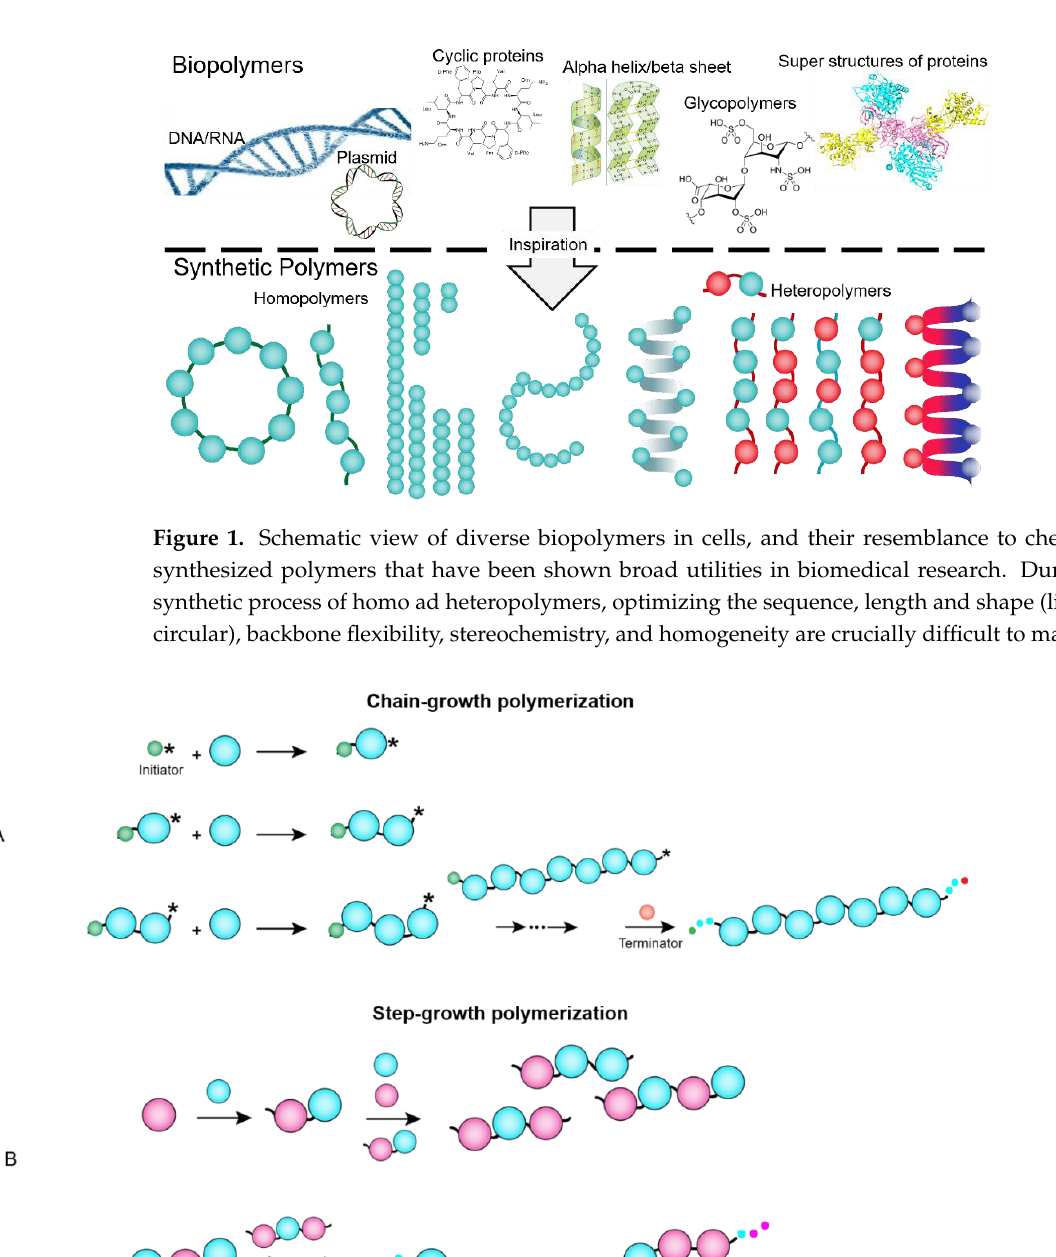
Figure 1. Schematic view of diverse biopolymers in cells, and their resemblance to chemically syn- thesized polymers that have been shown broad utilities in biomedical research. During the synthetic process of homo ad heteropolymers, optimizing the sequence, length and shape (linear vs. circular), backbone flexibility, stereochemistry, and homogeneity are crucially difficult to manage.